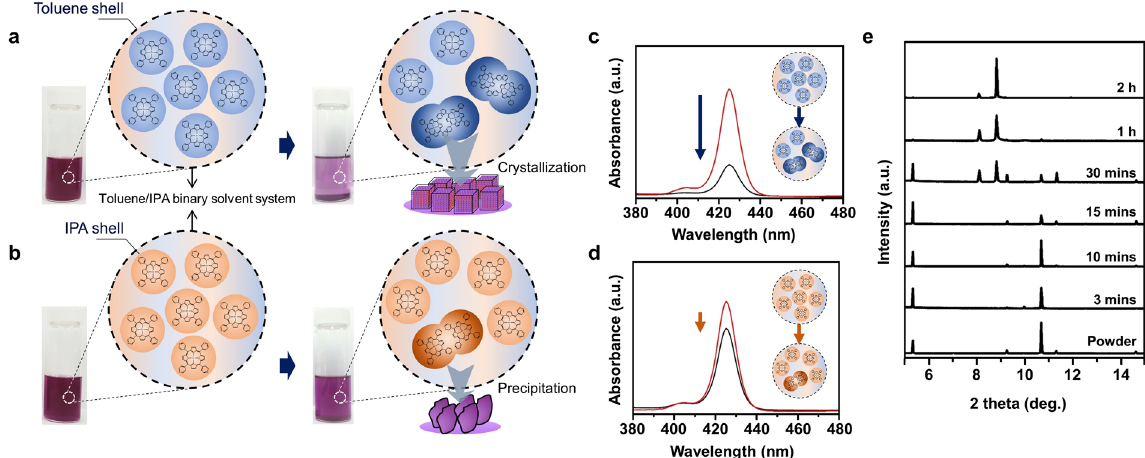
Figure 4. Extended first solvation shell mechanism and its indirect evidence via UV/VIS spectra and time- dependent XRD patterns. ( a ) Schemes and photographs of the r -ASC method, including toluene solvent-shelled ZnTPyP that promotes crystallization to cube crystal, and excess powder is dissolved to maintain supersaturated solution. ( b ) Schemes and photographs of the m -ASC method, including IPA solvent-shelled ZnTPyP that protects ZnTPyP to crystallize to ZnTPyP cube, and excess powder is precipitated. ( c , d ) UV/VIS spectra of as- received solution by the r -ASC method and the m -ASC method (red), respectively, and after 1 day (black). ( e ) XRD patterns of crystals grown by the r -ASC method depending on reaction